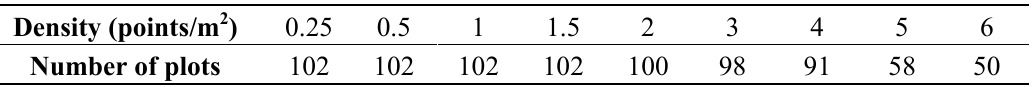
Table 2. Number of plots participating in the analysis as LiDAR data density